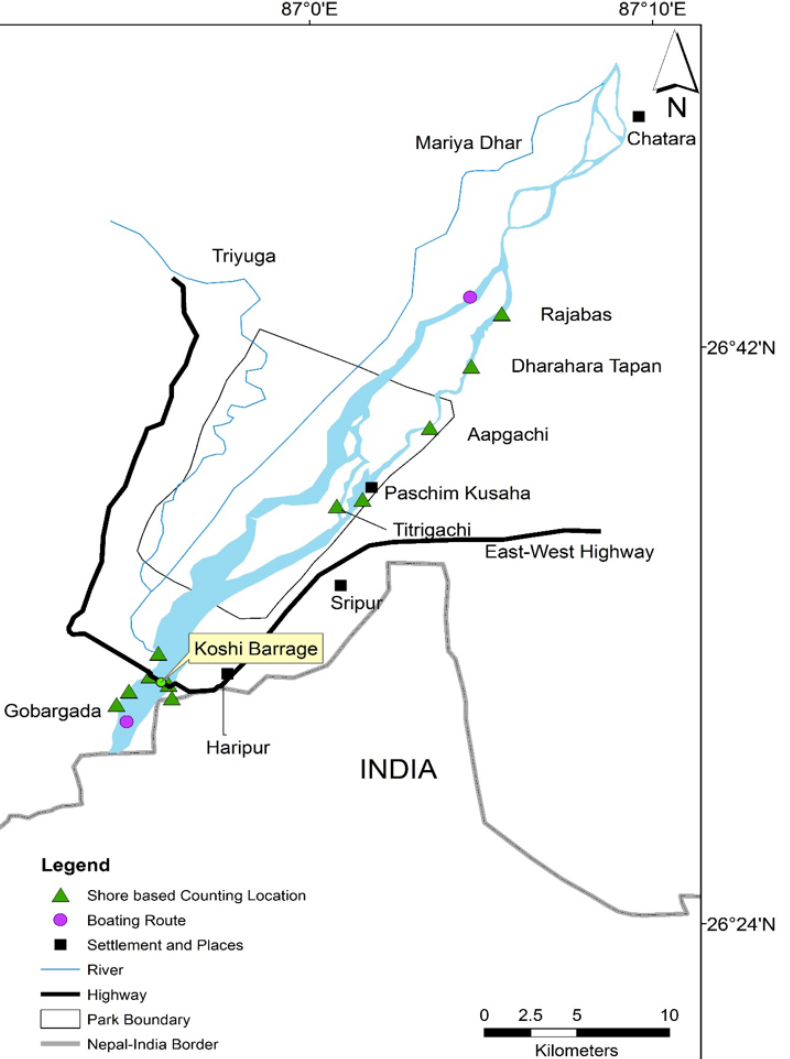
Figure 5. The surveyed areas in Koshi River,